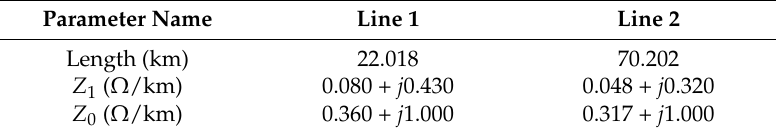
Table A1. The 220 kV transmission line parameters.